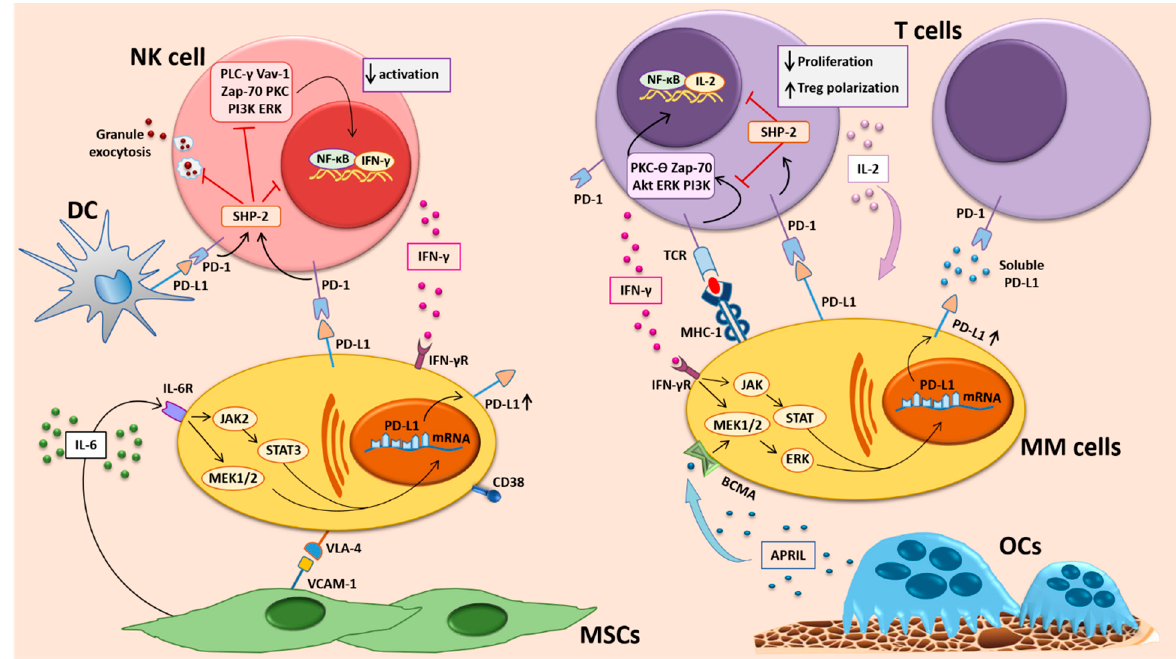
Figure 1. PD-L1/PD-1 distribution and mechanisms of regulation in the MM BM niche. Abbreviations: DC, dendritic cell; MSCs, mesenchymal stromal cells; MM, multiple myeloma; NK, natural killer; OCs, osteoclasts.